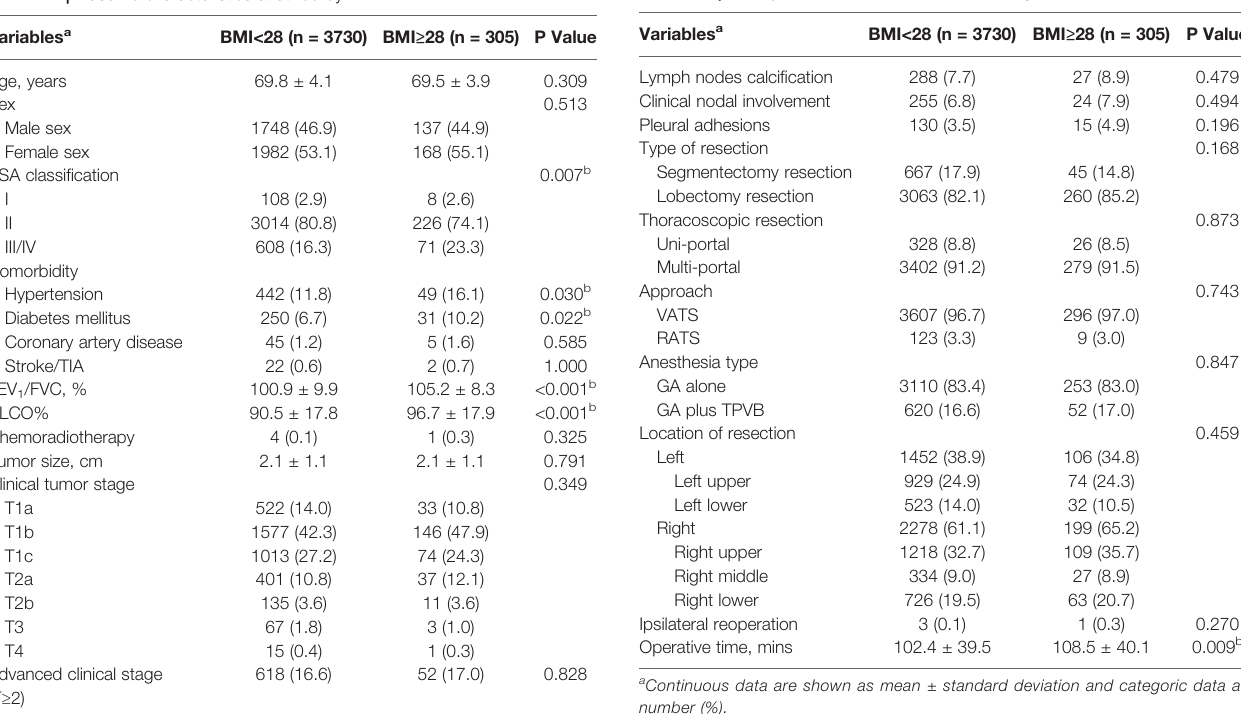
TABLE 1 | Baseline characteristics strati fi ed by BMI. TABLE 2 | Intraoperative characteristics strati fi ed by